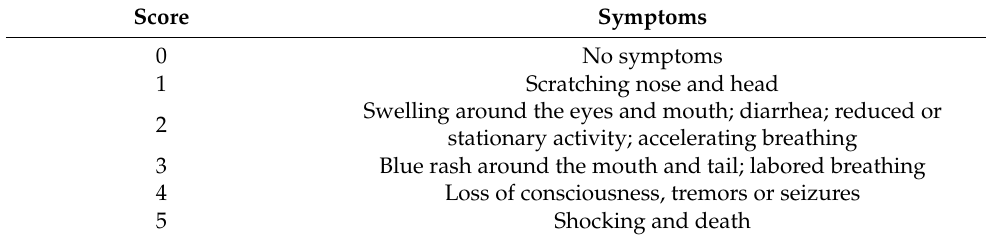
Table 1. Anaphylactic symptom scoring.